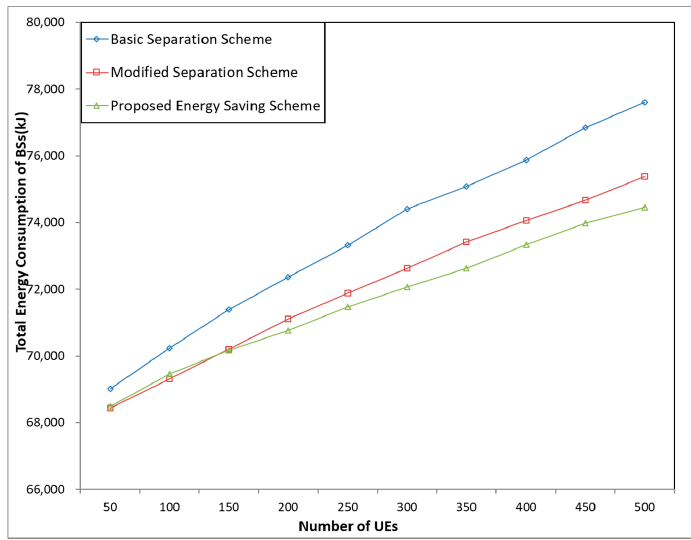
Figure 11. Total energy consumption of BSs.